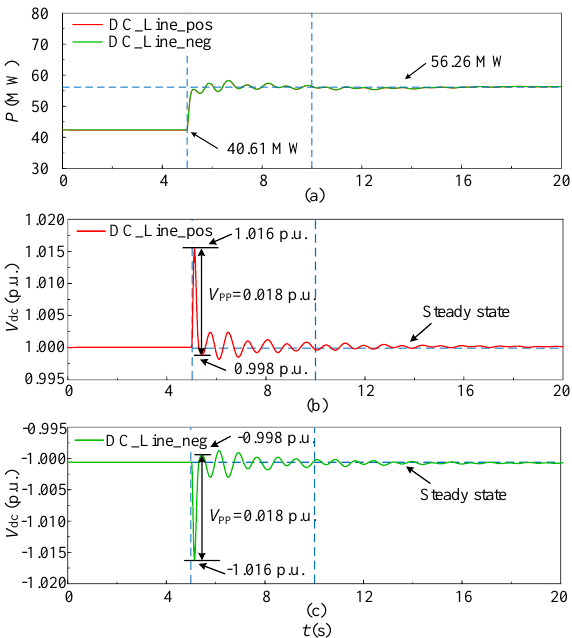
Fig. 6 When N-1 situation occurs on TL0405: (a) active power response on a single line of HVDC station; (b) voltage of the positive DC line in the HVDC station; (c) voltage of the negative DC line in the HVDC